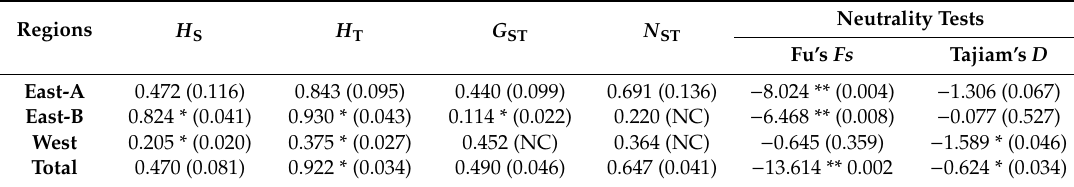
Table 2. Calculation of genetic diversity and molecular variance for chlorotype sequences of Nitraria tangutorum . H S , average gene diversity within populations; H T , total gene diversity; G ST , interpopulation di ff erentiation; N ST , number of substitution types; NC, not computed due to small populations; * p < 0.05, ** p < 0.01.